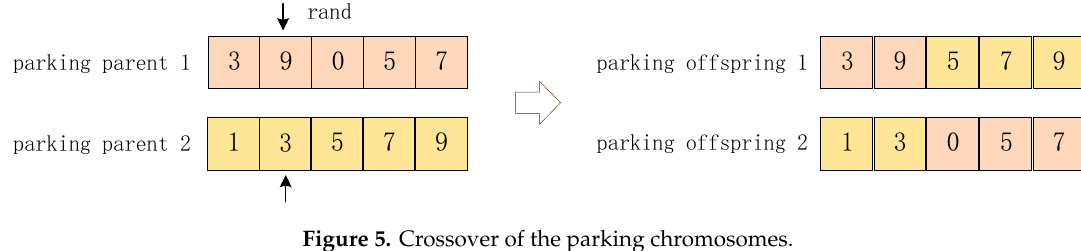
7 Figure 6. Paired combinations of the chromosomes after the crossover operation. 4.4. Layered Mutation Operation To prevent too many unreasonable chromosomes, the chromosome in the mutation operation also needs to be layered first as was done in the crossover operation, thus obtaining task (task chro) and parking (parking chro) chromosomes. The example is illustrated in Figure 7. parking chro task chro (b) Figure 7. An illustration of chromosome layering before the mutation operation: ( a ) chromosome before layering; ( b ) chromosome after layering. According to the difference between the task and parking chromosomes, different mutation operations are proposed in this paper, which are as follows. Task Chromosome. Since the task chromosomes after the mutation operation cannot contain duplicate genes or lack any gene, inversion and exchange mutations are used in the algorithm. One of these mutation options is randomly selected according to the probability before mutation to increase the population diversity. Inversion mutation: First, a fragment of the task chromosome (task chro) is randomly selected, and then the genes in this fragment are arranged in reverse order to obtain a new task chromosome (new task chro). For example, as shown in Figure 8a, the new task chro “8 4 2 6” is obtained by randomly selecting fragment “6 2 4” in task chro “8 6 2 4” and arranging “6 2 4” in reverse order. Exchange mutation: Two genes in the task chromosome (task chro) are randomly selected, and a new task chromosome (new task chro) is obtained by exchanging the two genes. For example, as